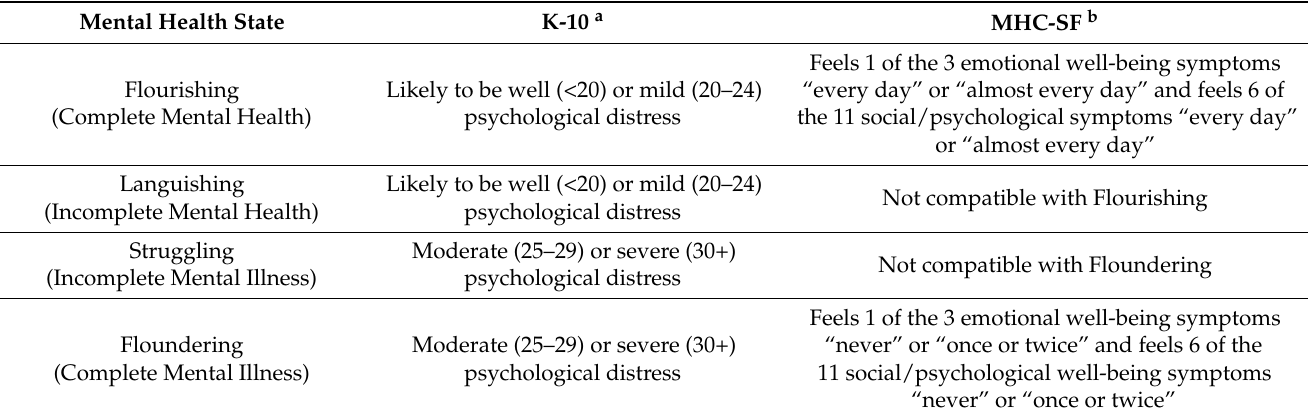
Table 1. Criteria used to categorise participants into complete mental health